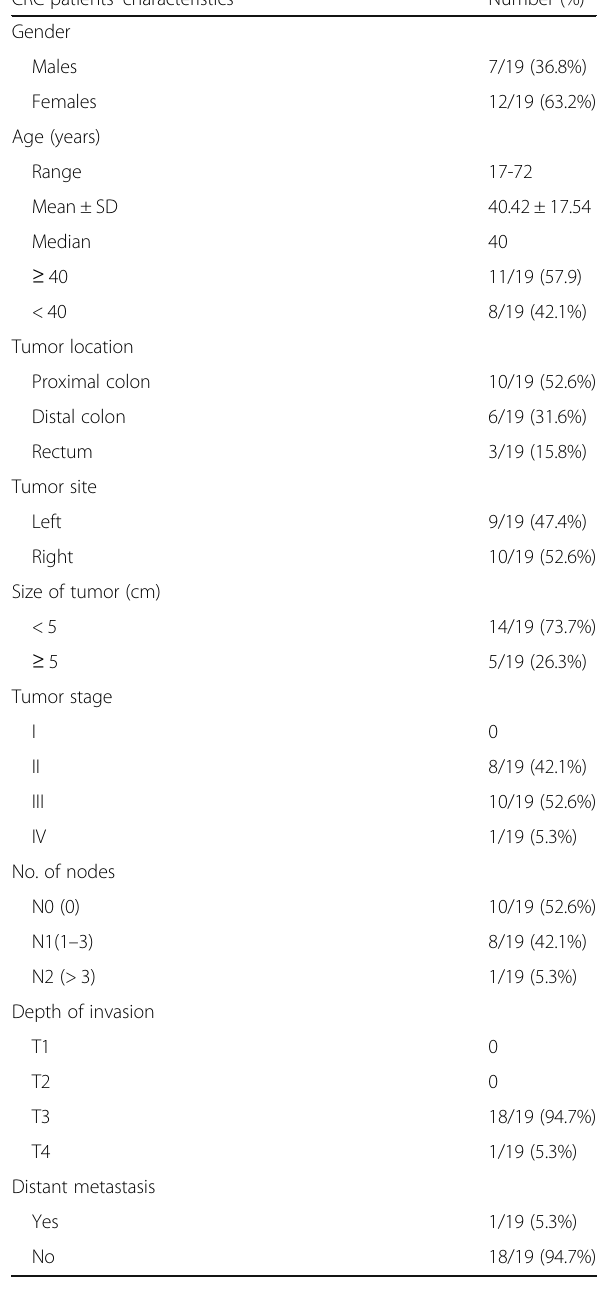
Table 1 Clinicopathological features of the studied CRC